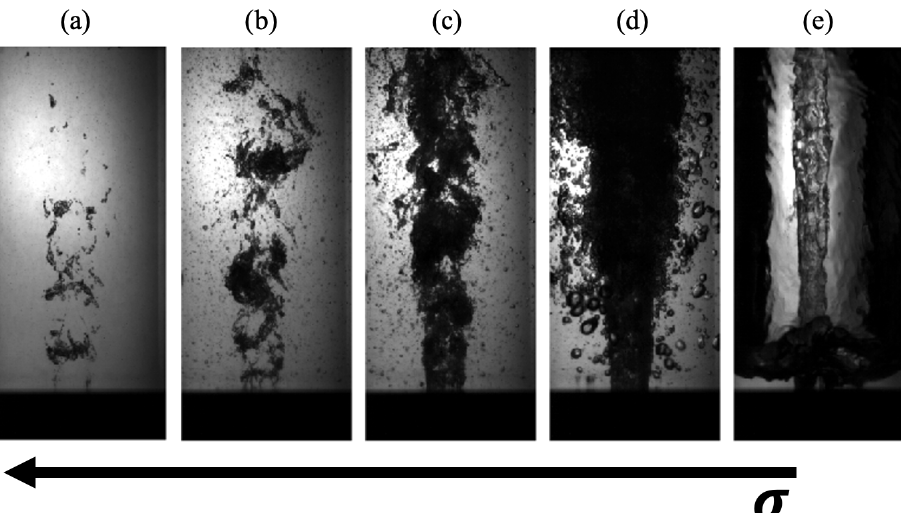
Figure 2. Examples of the cavitation regimes through a cylindrical orifice for decreasing σ . The sparse bubbling at higher σ ( a ) evolves in vapor clouds shedding downstream of the orifice as σ reduces ( b,c ). In ( d ), the production of vapor is more intense, and a vapor column covers the entire field of view downstream of the orifice. Finally, super-cavitation is visible in ( e ) for σ ≈ 1. Figure reproduced from [7], Copyright (2021), with permission from